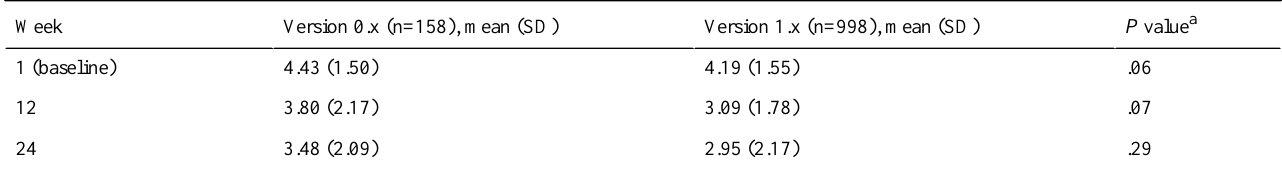
Table 4. Mean weekly in-app reported pain levels at baseline and at 12 and 24